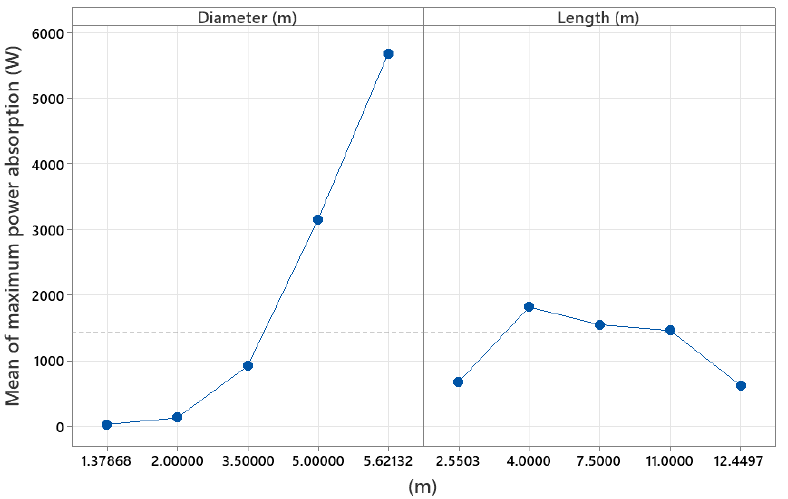
Figure 16. Main Effect Diagram for Maximum Power Absorption.